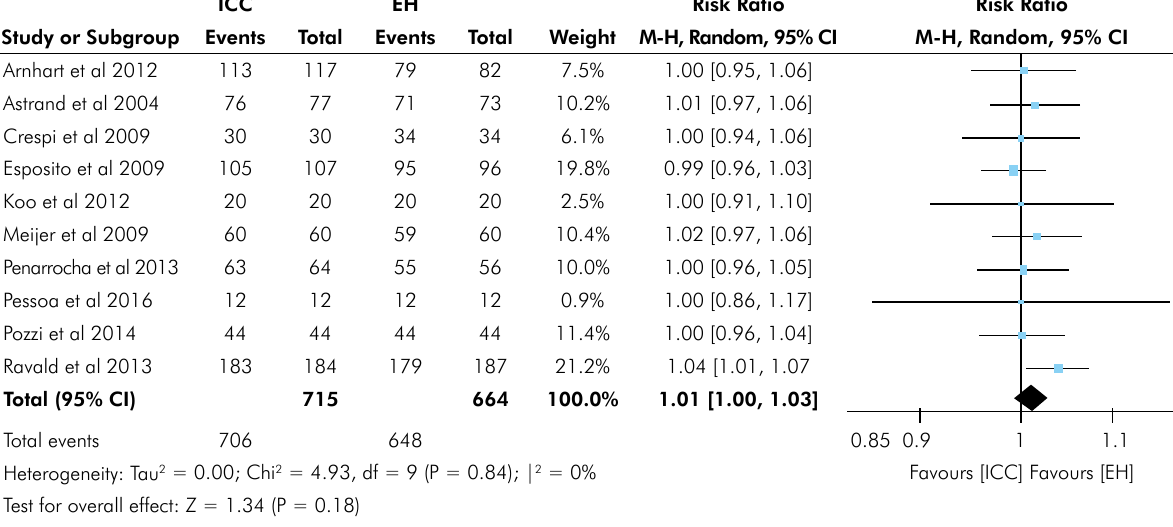
Figure 6. Implant survival rates after 1 year.